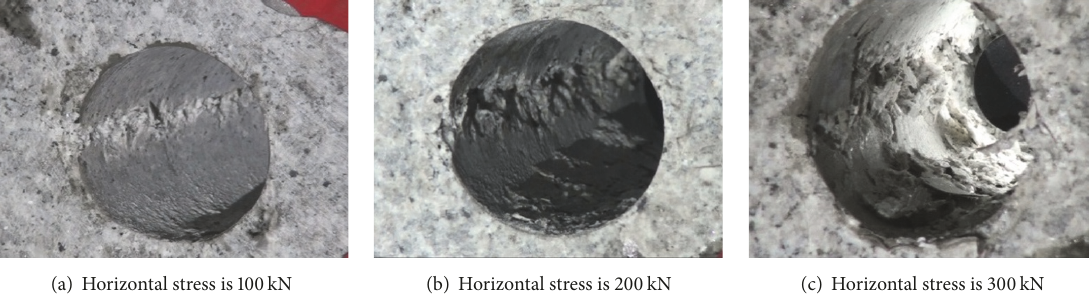
Figure 6: Final fracturing morphology of rockburst in tunnel under different horizontal